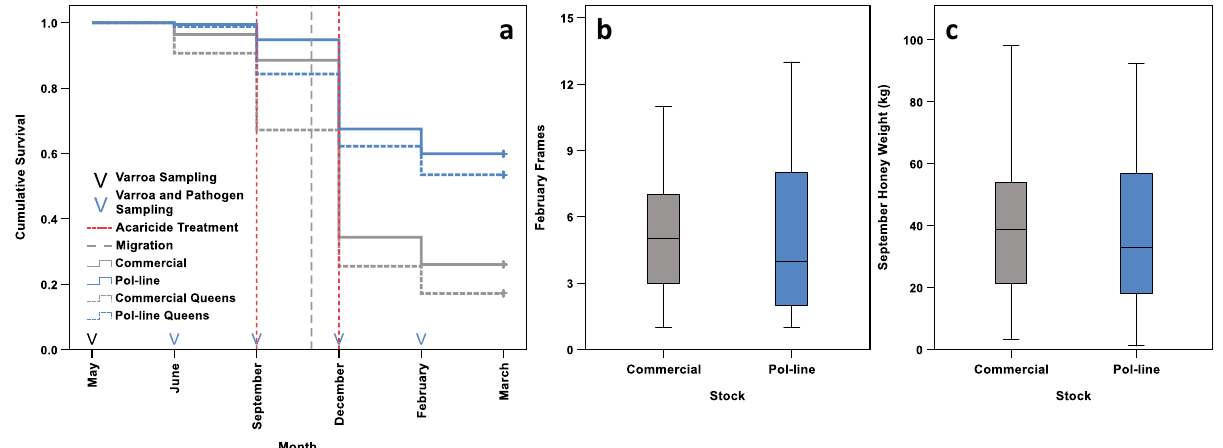
Figure 2. ( a ) Survival proportions of colonies (solid lines), and queens (dashed lines), of each stock (Commercial, grey; Pol-line, blue), across the course of the study ( N Commercial = 193, N Pol-line = 173). Dashed vertical lines indicate the timings of management events (acaricide treatment, red; migration for overwintering, grey). Arrows designate the timings of sampling ( Varroa sampling, black; Varroa and pathogen sampling, blue). Significant differences between stocks were present in colony survival (hazard ratio = 0.408, χ 2 = 122.800, d.f. = 1, N = 366, P < 0.001), and queen survival (hazard ratio = 0.355, χ 2 = 234.388, d.f. = 1, N = 366, P < 0.001). ( b ) Frames of adult bees in surviving colonies in February ( N Commercial = 50, N Pol-line = 103). Frame counts did not differ significantly between the two stocks ( χ 2 1 = 2.272, N = 153, P = 0.131). ( c ) Honey production in September ( N Commercial = 141, N Pol-line = 137). Honey production did not differ significantly between stocks ( χ 2 1 = 0.476, N = 278, P =